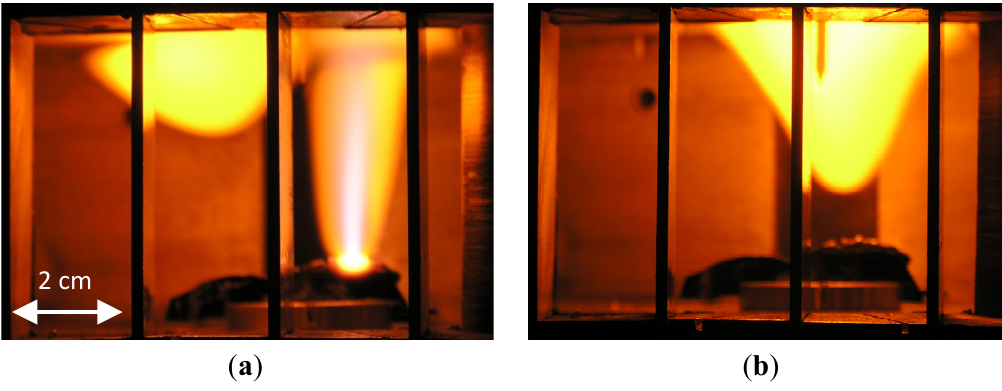
Figure 2. ( a ) A fire-column ejected from a hotspot created by localized microwaves in silicon, feeding an adjacent secondary fireball (plasmoid); and ( b ) The fireball evolved, floating in the air atmosphere within the microwave cavity